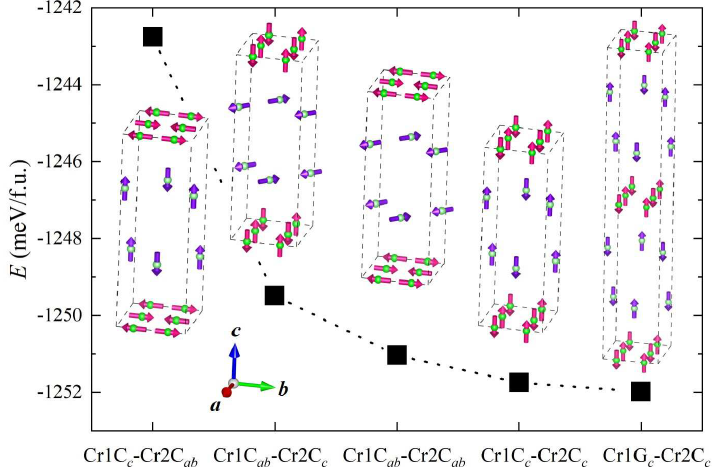
Figure 7. Calculated magnetic energies for the antiferromagnetic states with different spin directions in Cr(1) ( top and bottom ) and Cr(2) ( middle ) sites of Sr 2 Cr 2 AsO 3 . The ordered moments of Cr(1) and Cr(2) are calculated to be 2.52 and 2.41 µ B , respec- tively. One notes that the magnetic moment of Cr(1) is reduced by ∼ 0.5 µ B , compared with